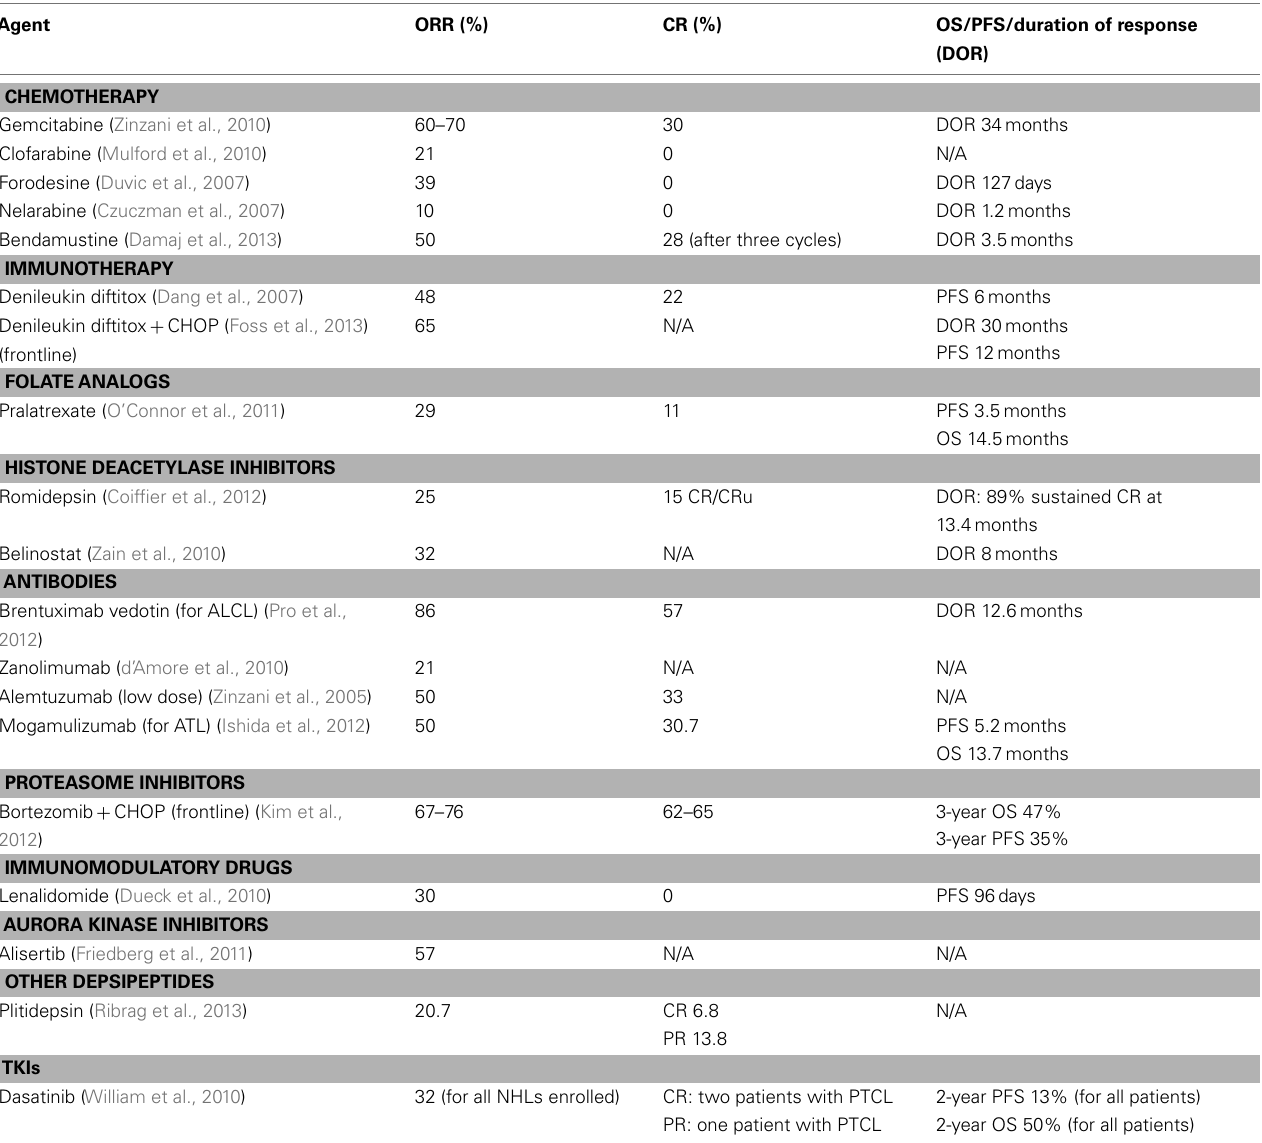
Table 2 | Novel agents for treatment of PTCL (in the relapsed setting, unless otherwise